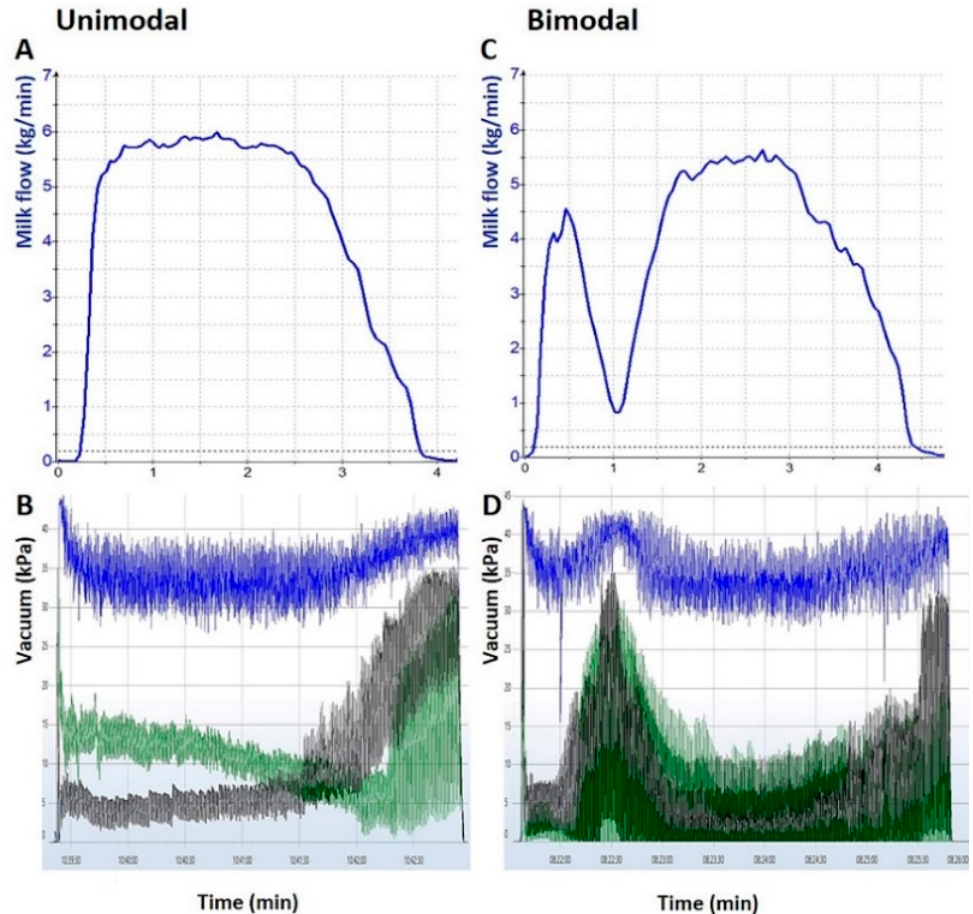
Figure 1. Comparison of unimodal ( A , B ) and bimodal ( C , D ) milk ejection as assessed with the Lactocorder (WMB AG, Balgach, Switzerland; A and C ) and the VaDia (Biocontrol, Rakkestad, Norway; B and D ). The Lactocorder graphs show milk flow as milk (kg/min) and the VaDia graphs depict the milking as vacuum (kPa) over time (min). ( B and D ) Channel 2 (blue line) represents the vacuum measured in the short milk tube. Channels 3 and 4 (green and black lines) represent the vacuum measured in the right hind and left front mouthpiece chambers, respectively.